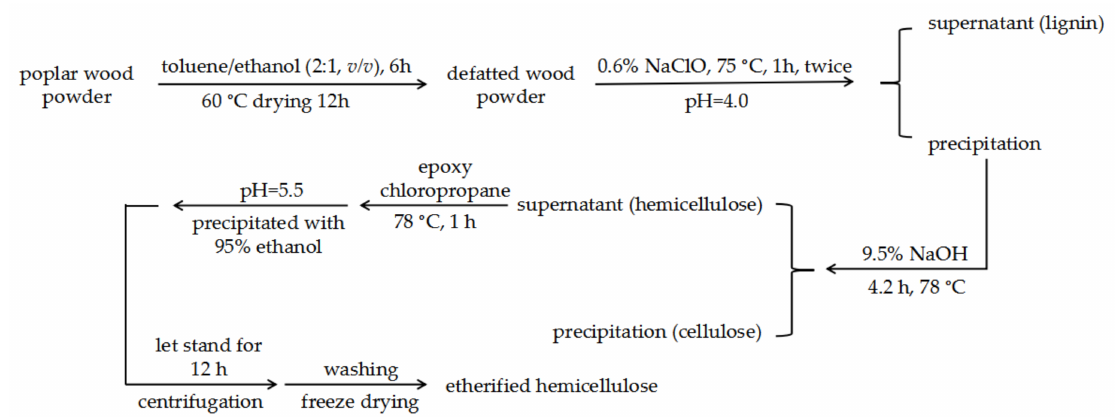
Figure 1. The flow chart of single-step synthesis etherified hemicellulose.